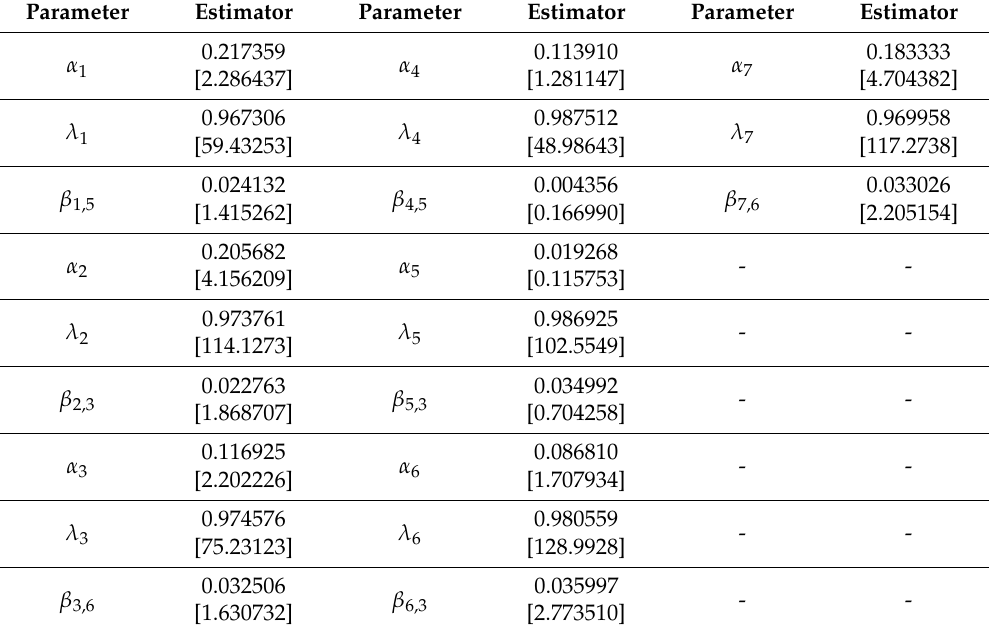
Table 1. Parameter fitting results of the optimal lag order regression model with weight function. Parameter Estimator